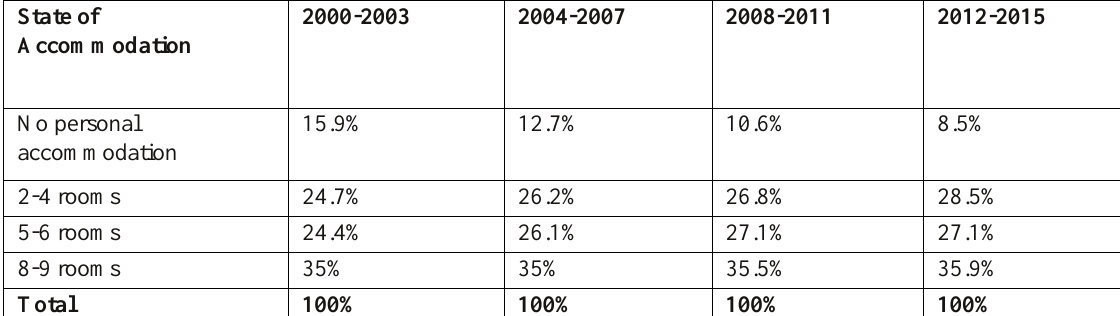
Table 8: Distribution of Respondents According to Access to Domestic Housing